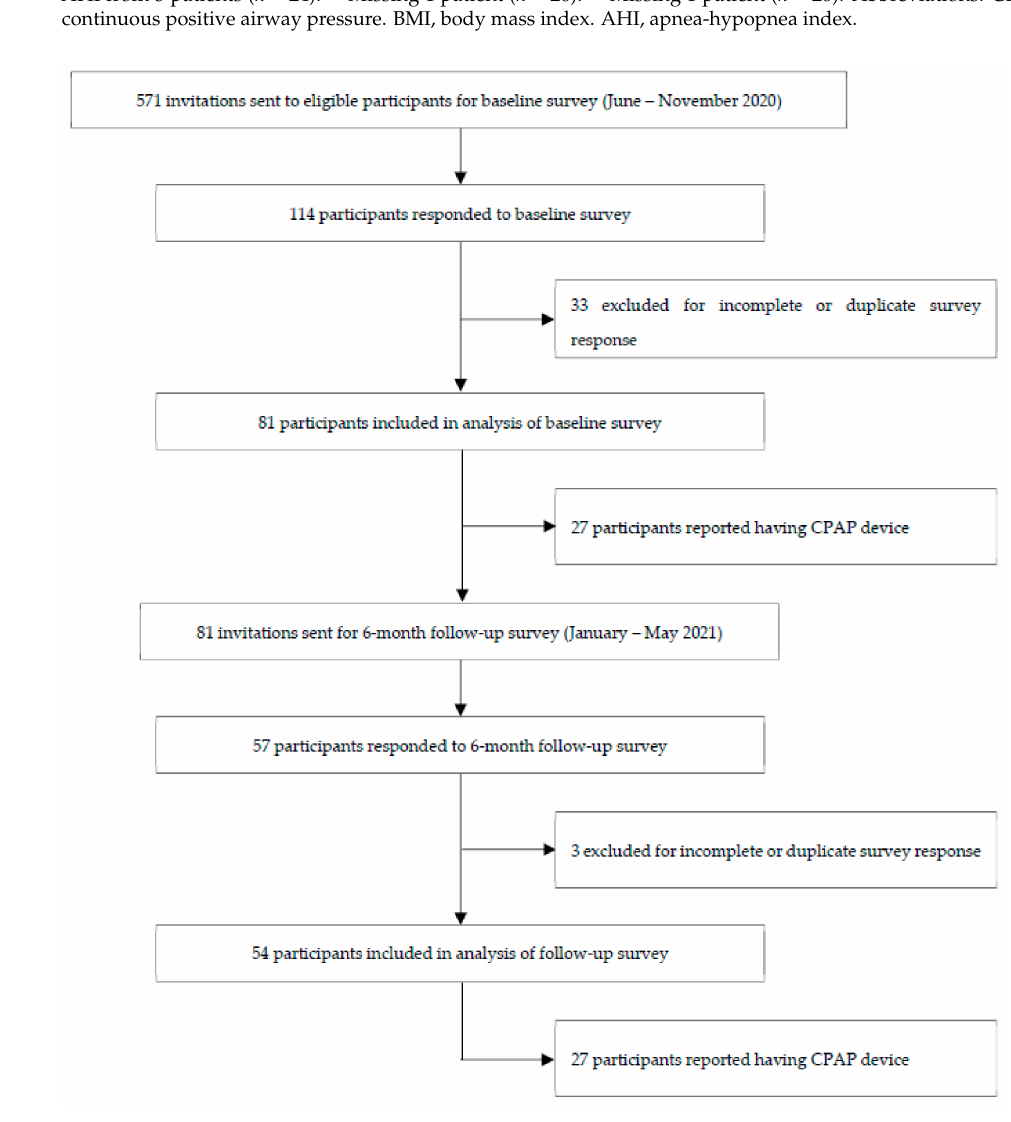
Figure 1. Flow diagram of participant